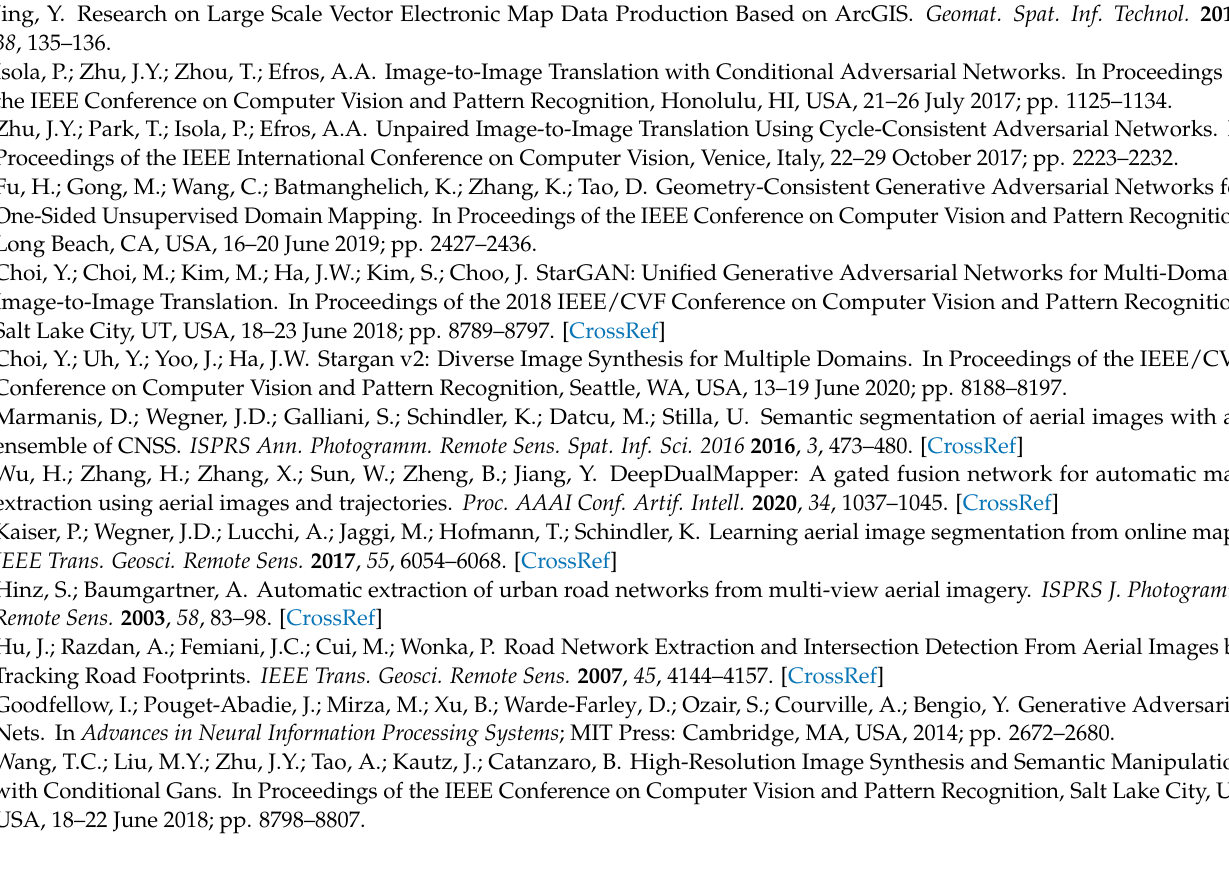
Figure A2. Example results in the Wuhan